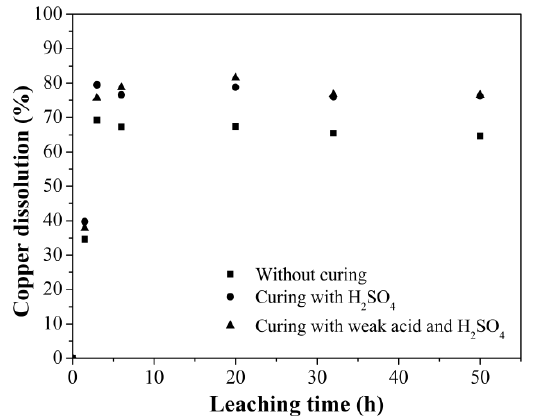
Figure 4. Copper leaching test with sulfuric acid and water as a leaching agent.